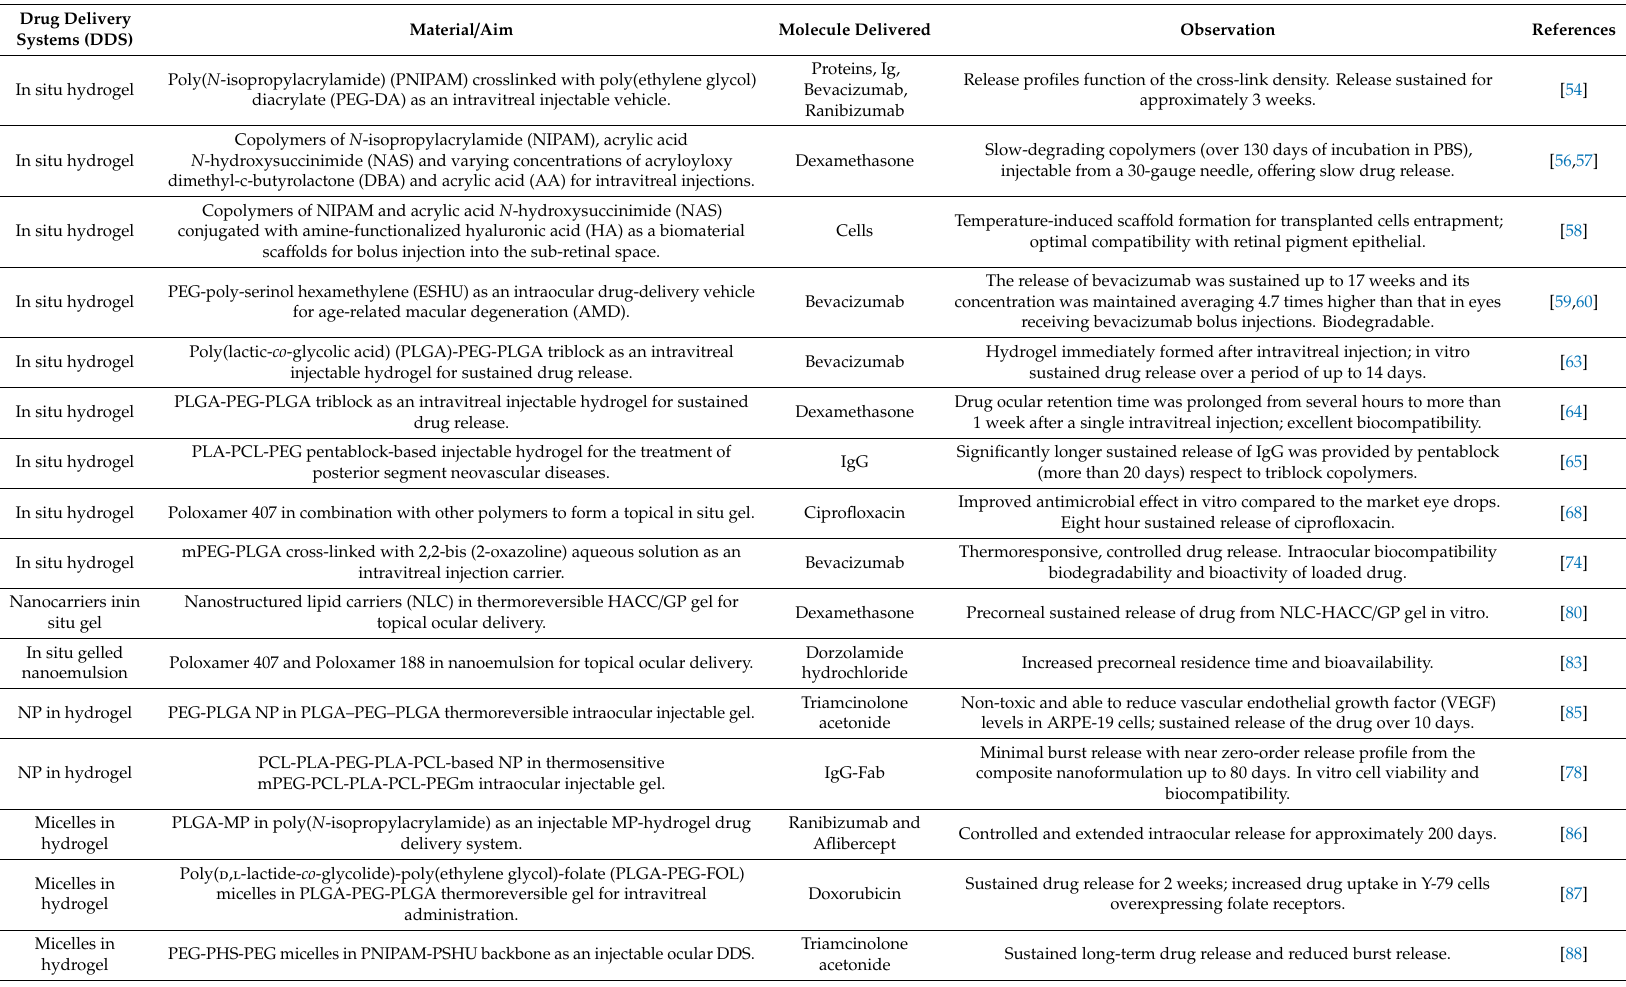
Table 2. A summary of the thermosensitive systems (hydrogels and composites) developed for ocular drug